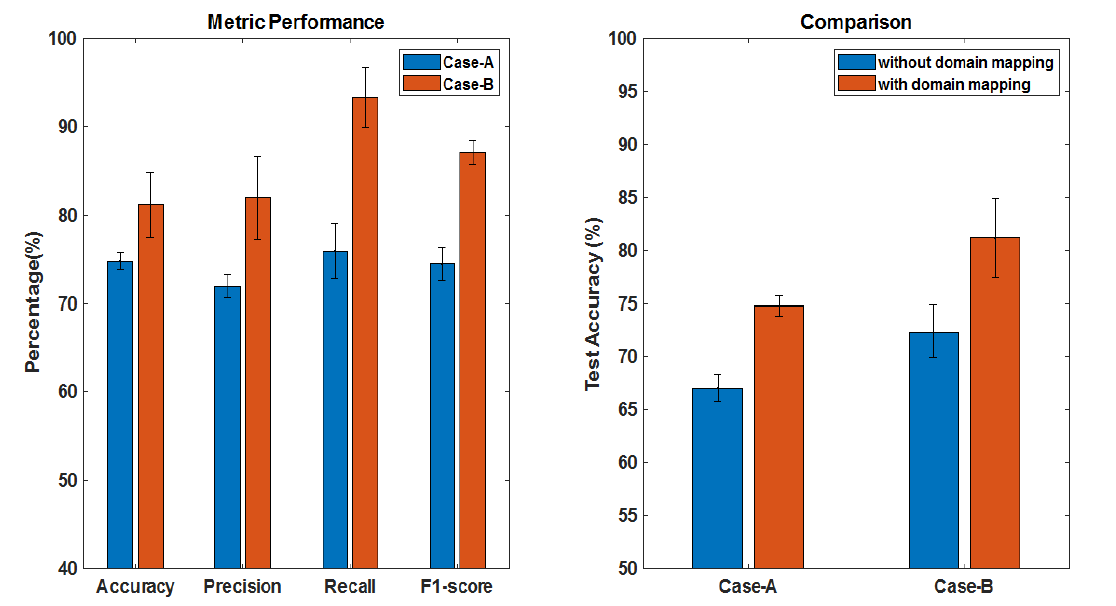
Figure 10. Left: Test performance of the proposed scheme (averaged over 5 runs) for both case studies. Right: Test performance of with/without domain mapping for both case